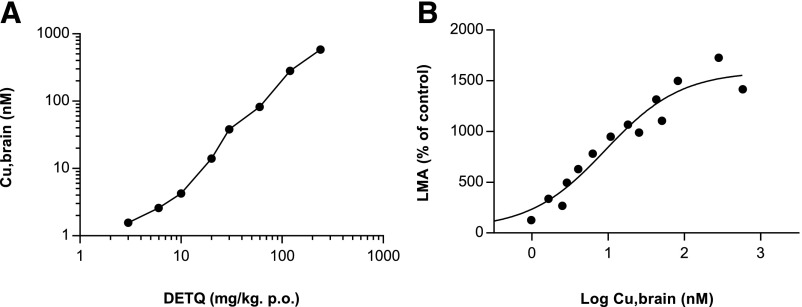
Unbound brain levels of DETQ measured immediately after LMA testing. (A) Dose dependence of calculated unbound brain levels. (B) Relationship between LMA and unbound brain levels. Each point is the mean of brain levels from three animals. The curve is the best fit to a four-parameter model. Best-fit values ± S.E. are: bottom 40% ± 127% of control; top 1,590% ± 130% of control; EC50 9.2 ± 3.1 nM; Hill coefficient 0.88 ± 0.21.